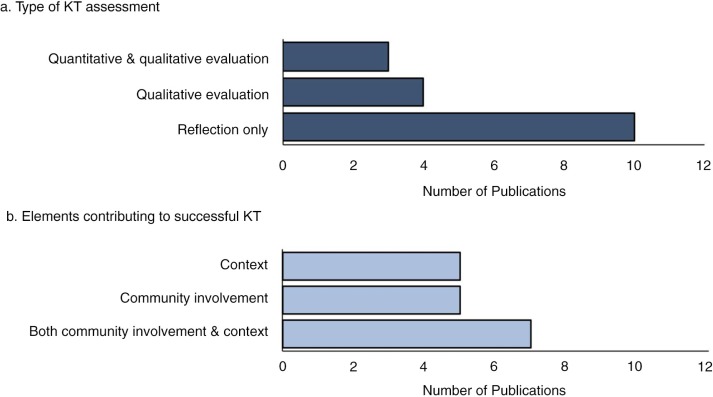
Graphs displaying (a) the type of knowledge translation (KT) assessment (reflection (50–53,55–57,75–77), qualitative evaluation alone (45,47–49) and both quantitative and qualitative methods (46,54,76)), and (b) the elements that the author attributed to KT success (necessity of community involvement (46,50,51,56,76), context (45,47,49,53,54) or both (31,48,51,52,57,75,77)).